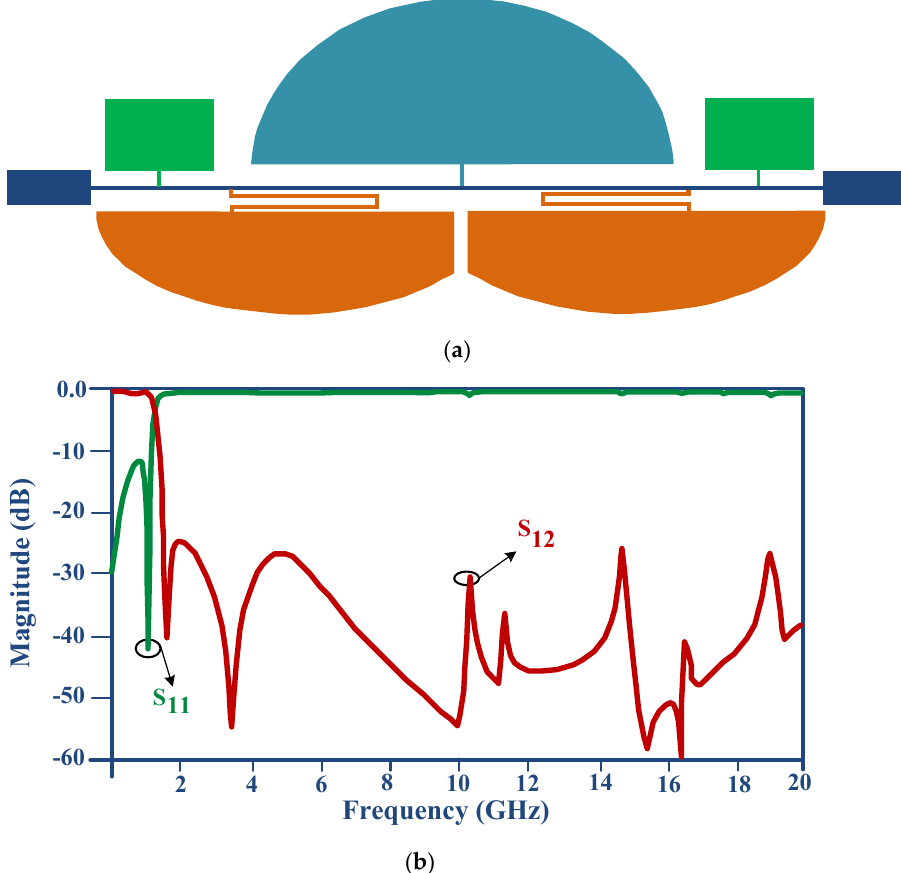
Figure 9. The square-shape attenuator resonator ( a ) structure and ( b ) its frequency response.